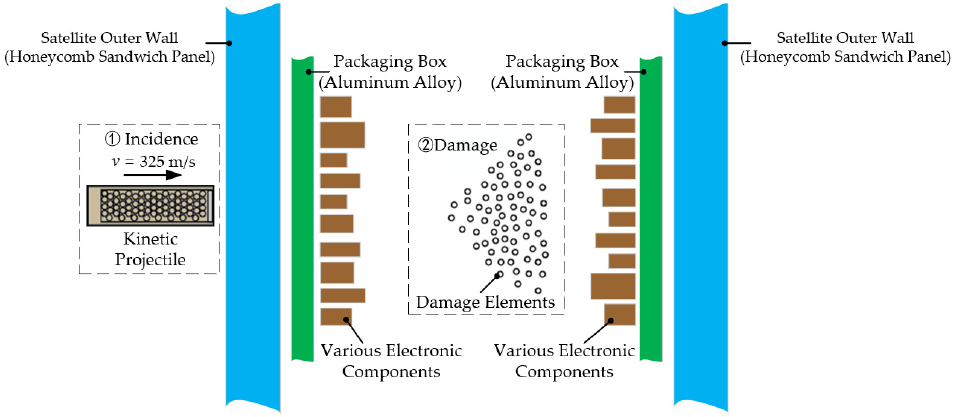
Figure 3. Mechanism of kinetic projectile damage to orbiting spacecrafts.